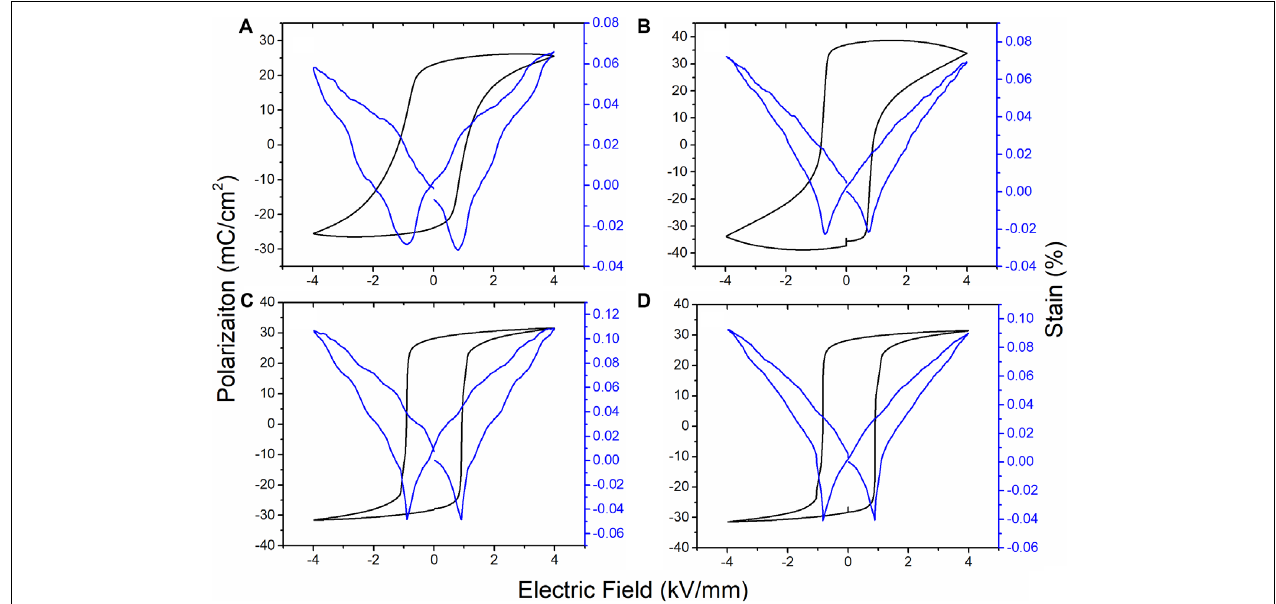
FIGURE 7 | Polarization and strain vs. electric field for (A) x = 0; (B) x = 0.5 mol.%; (C) 0.75 mol.%; and (D) x = 1 mol.%.